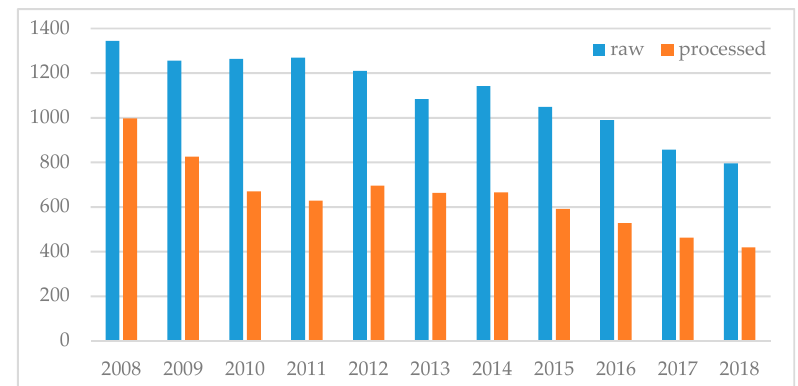
Figure A1. The sample size of each year from 2008–2018 (“raw”: samples with yield records from USDA NASS; “processed”: samples with complete input variables).